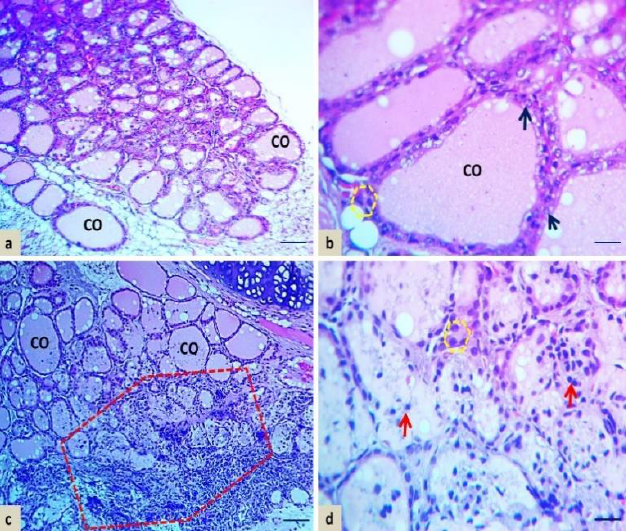
Figure 8. Microscopic photographs of thyroid gland sections of male Wister rats in negative control ( a and b ) and diabetic control ( c and d ). a, Well organized thyroid follicles that contain a large amount of colloid (CO) (H&E, 100×); b , normal height of follicular cells (black arrow) and intact parathyroid cells (yellow polygonal) (H&E, 400×). c , distorted thyroid gland (red polygonal) with degeneration of follicular cells and reduction of colloid (CO), inflammatory cells infiltration (H&E, 100×); d , focal necrosis of thyroid follicular cells (red arrows) and parafollicular cells (yellow polygonal) (H&E, 400×)